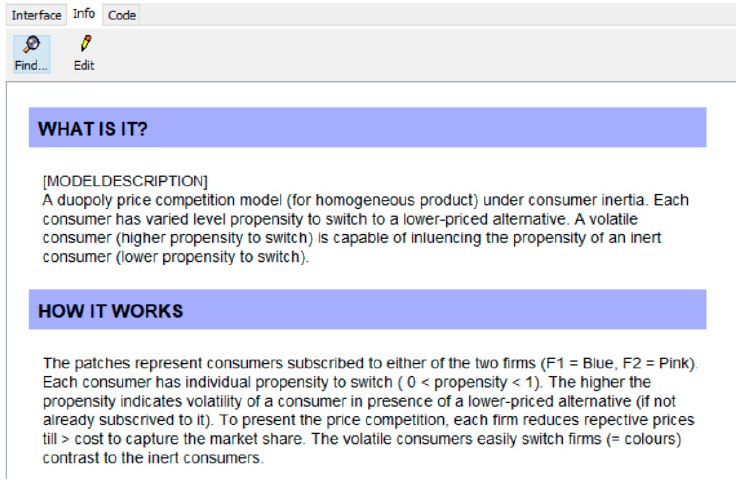
Figure 5. NetLogo Info window.